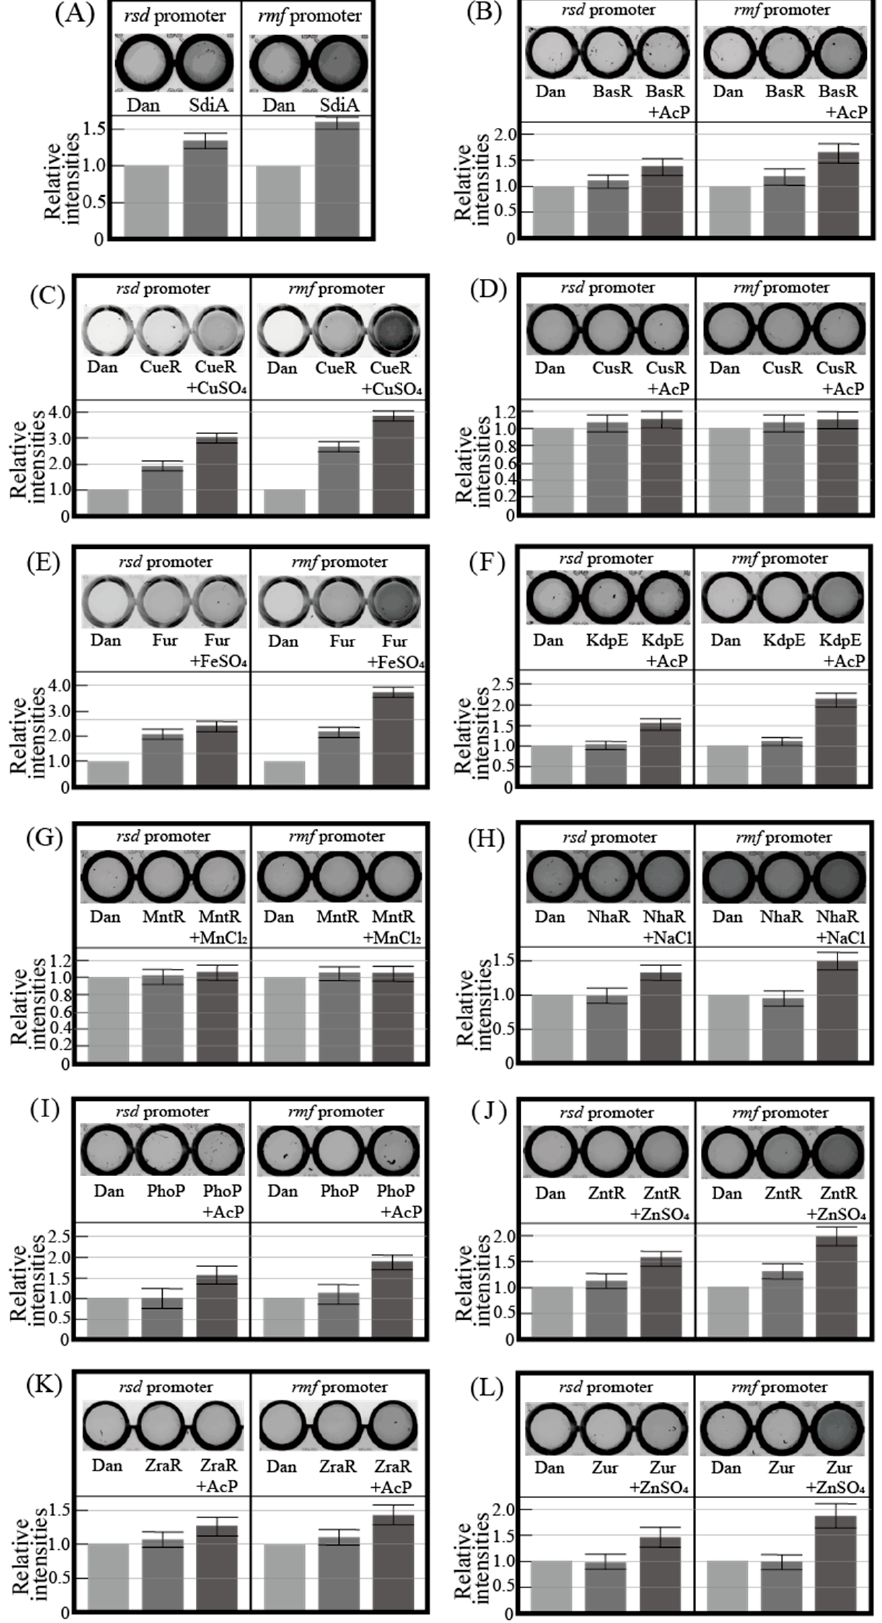
Figure 3. Fluorescence images of plate wells containing solutions obtained from the magnetic bead assay and the relative fluorescence intensities. Each upper panel indicates a scanned image, and each lower panel indicates a graph normalized against the fluorescence intensity for Dan. The